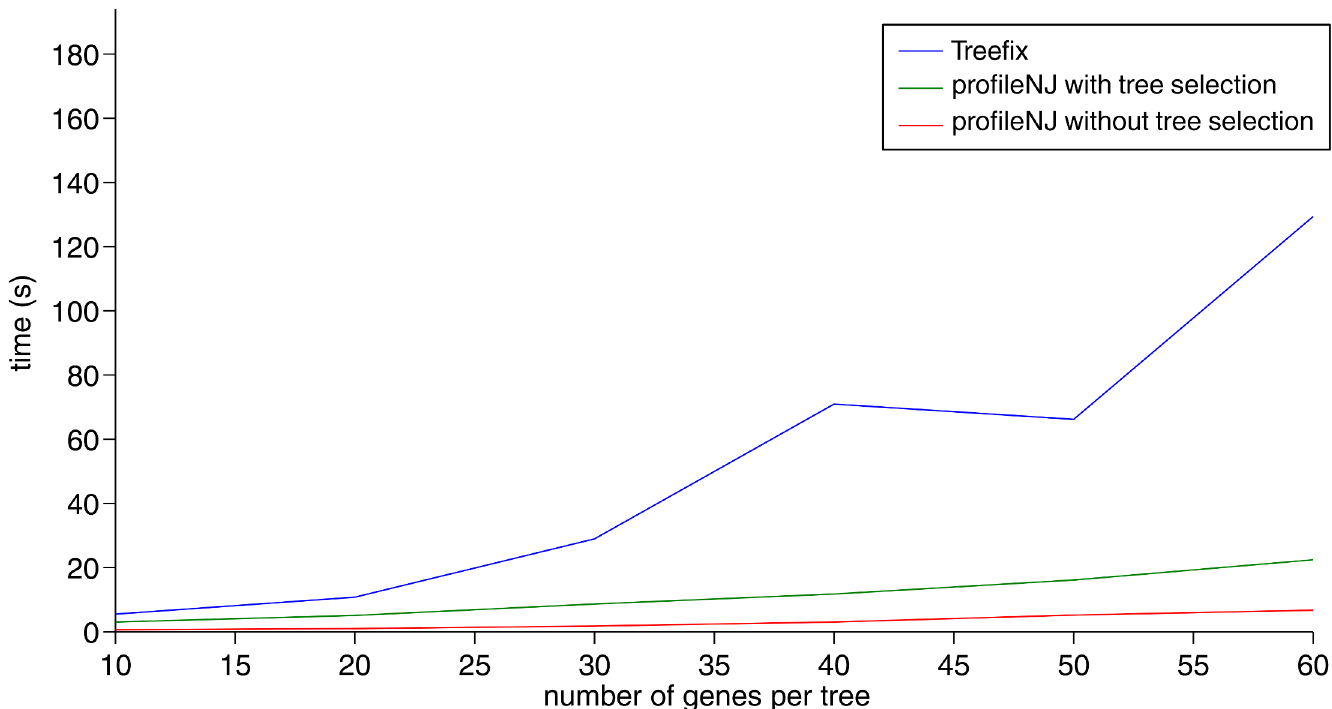
Fig 3. Run time of TreeFix and ProfileNJ for increasing size of gene tree.